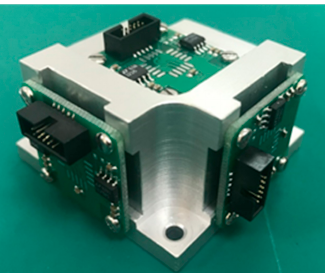
Figure 2. Photo of the Micro Electro Mechanical System (MEMS) acceleration sensor, in which three MSV6000-02 accelerometers are mounted orthogonally to each other.